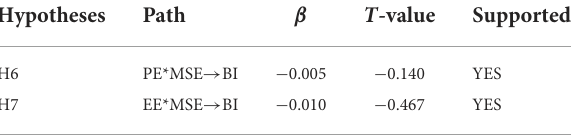
TABLE 8 Summary of the moderation